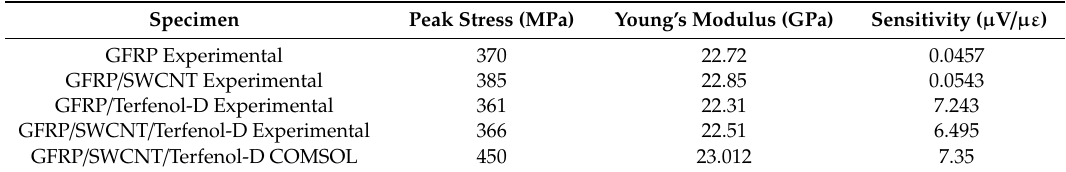
Table 2. Comparison of experimental sensor sensitivity with COMSOL Multiphysics ®